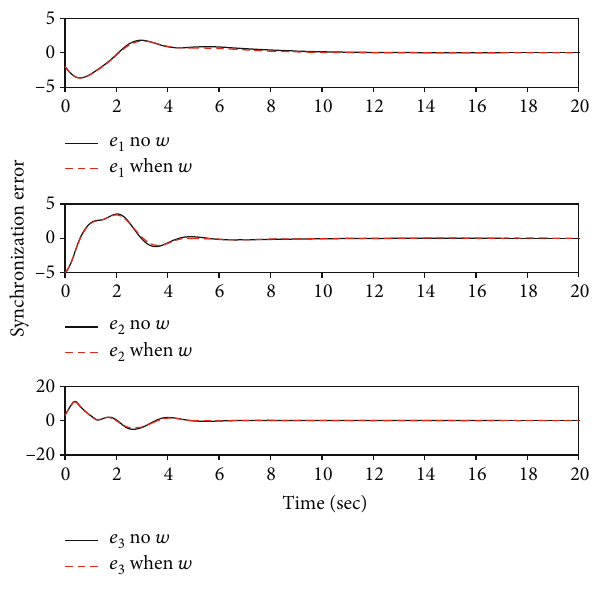
Figure 10: Synchronization error of states.